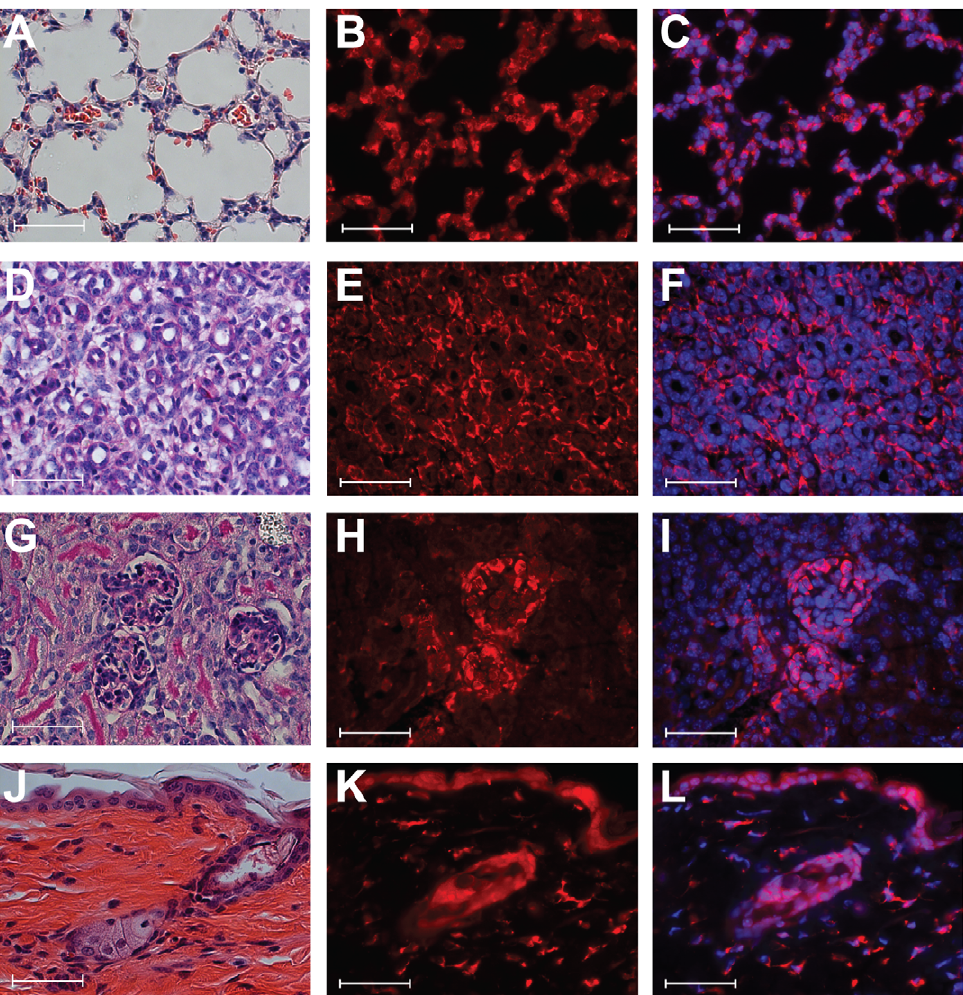
Figure 1. Immunofluorescence staining of CRTAP protein in wild-type mouse tissues. ( A ) Lung H&E stained section. ( B ) CRTAP protein expression in all pneumocytes. ( C ) Merge of CRTAP with DAPI. ( D ) Kidney medulla H&E stained section. ( E ) CRTAP protein seems to localize to peritubular capillaries. ( F ) Merge of CRTAP with DAPI. ( G ) H&E stained section of kidney glomeruli. ( H ) CRTAP protein is in visceral and parietal epithelial cells of the glomerulus. ( I ) Merge of CRTAP with DAPI. ( J ) Skin H&E stained section, including hair follicle. ( K ) CRTAP protein is seen as intense foci in fibroblasts distributed throughout the dermis. Epidermal and follicular staining is consistent with background staining seen in Crtap-/- skin stained with anti-CRTAP antibody (data not shown). ( L ) Merge of CRTAP with DAPI. All pictures are at 40 6 magnification, and scale bars are 50 micrometers. Specificity of staining was confirmed in all cases by using the same CRTAP antibody onto Crtap-/- tissue sections (data not shown).